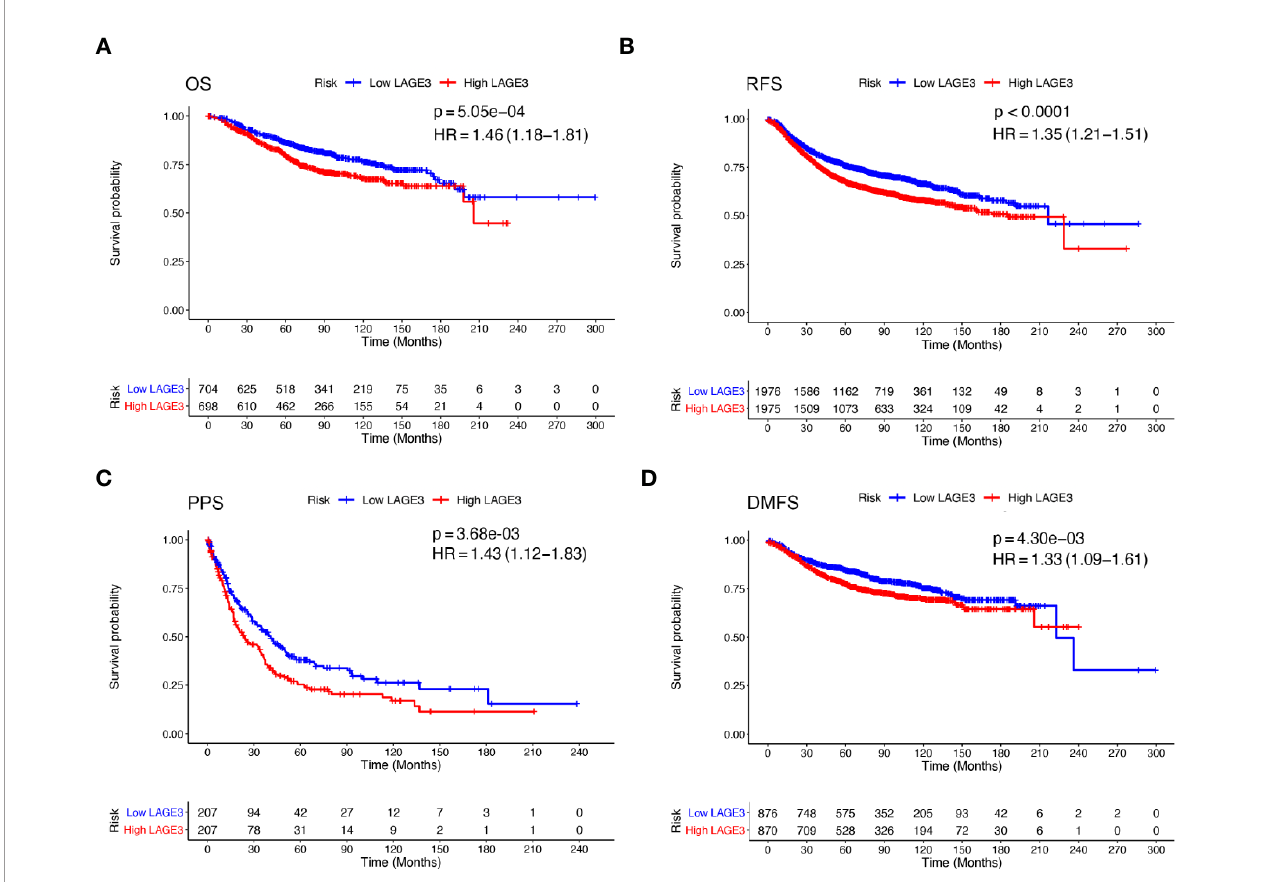
FIGURE 4 | Prognostic value of LAGE3 in BC patients in K-M plotter database. (A – D) OS, RFS, PPS, and DMFS curve of high and low LAGE3-expressing BC patients. OS, overall survival; RFS, relapse-free survival; PPS, post-progression survival; DMFS, distant metastasis-free